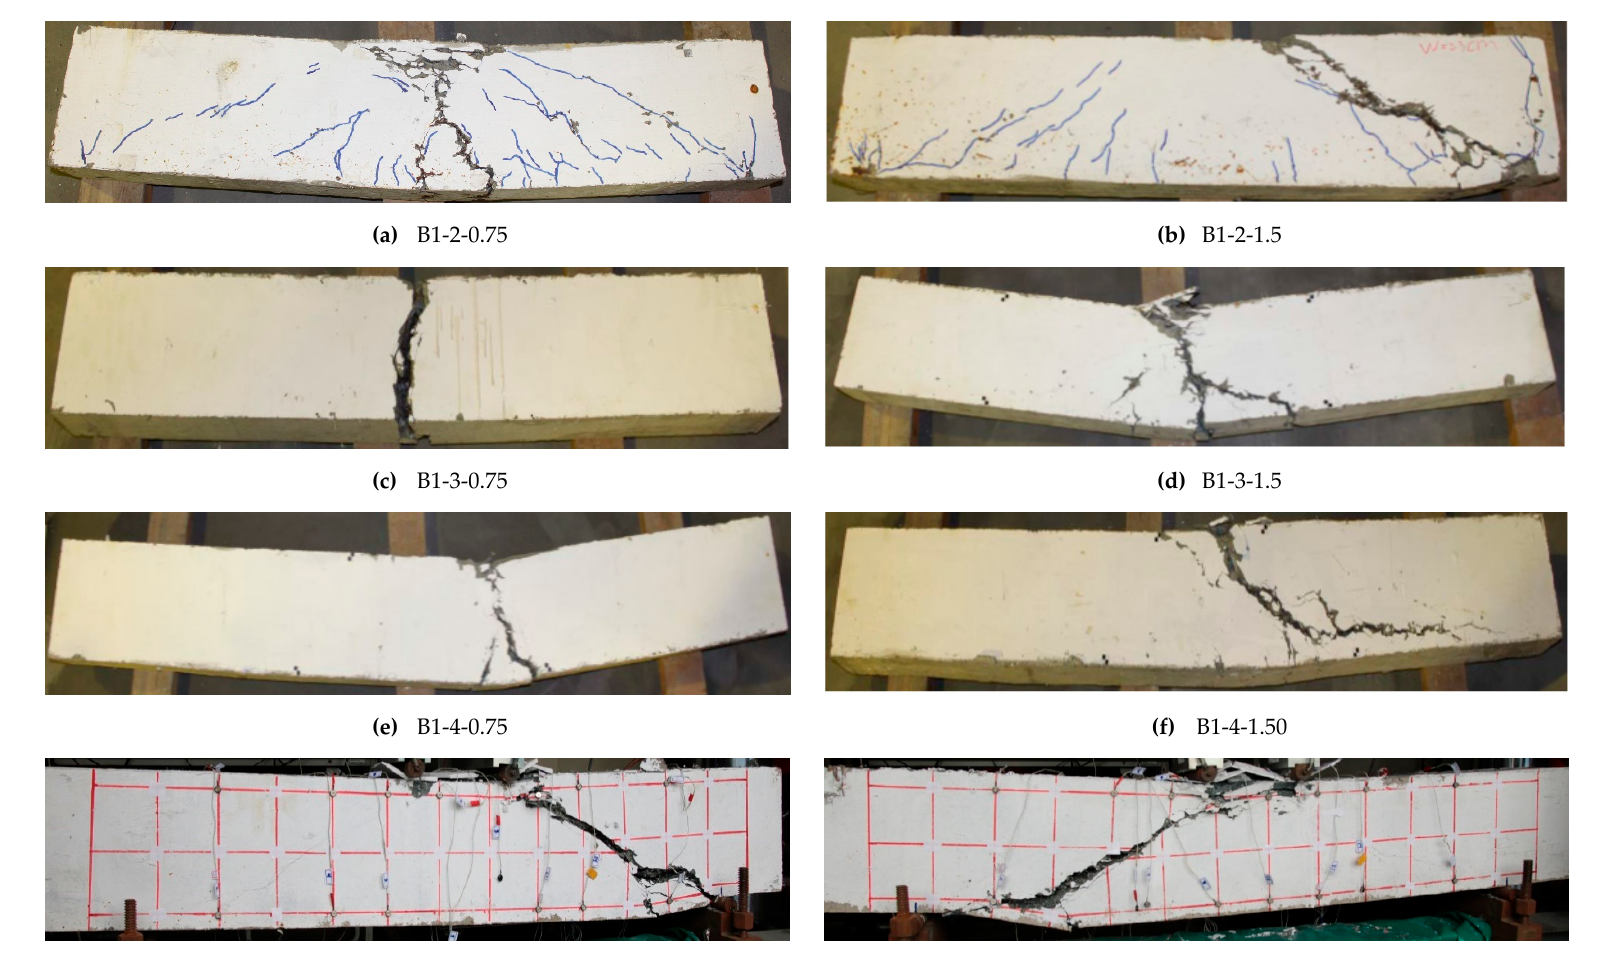
Figure 6. The final appearance of beam specimens at the end of tests.